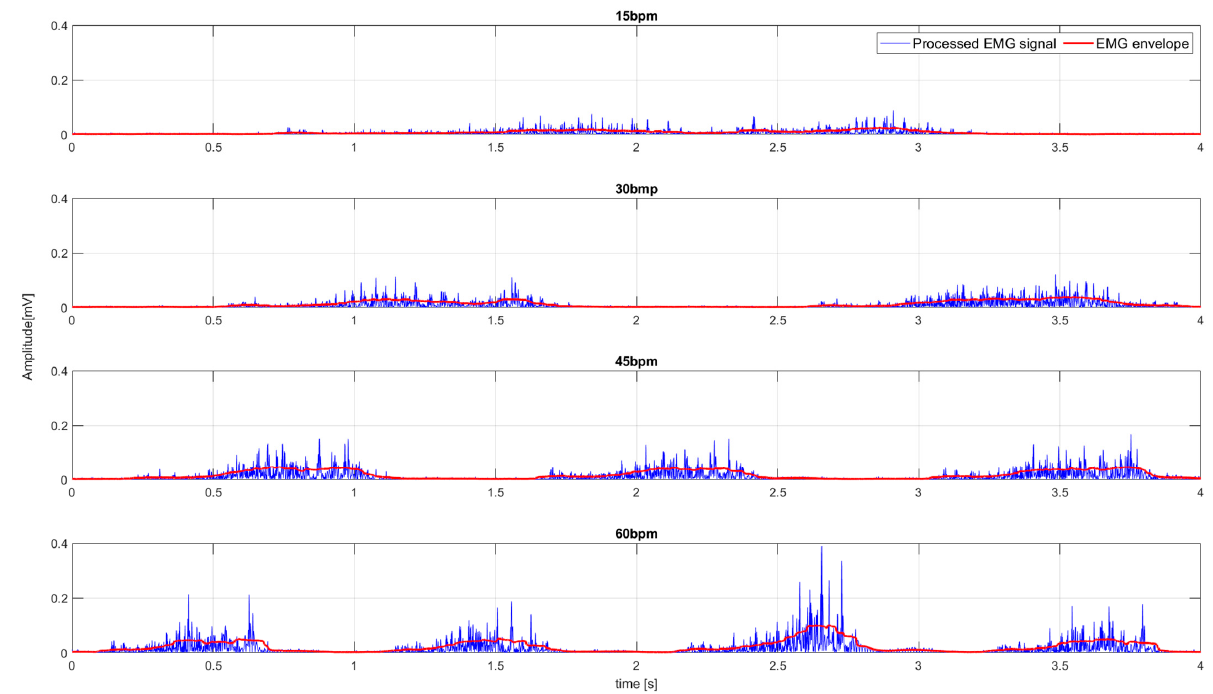
Figure A1. Muscle activation estimation: Processed EMG signal (blue line) and EMG envelope (red line) in task E1.